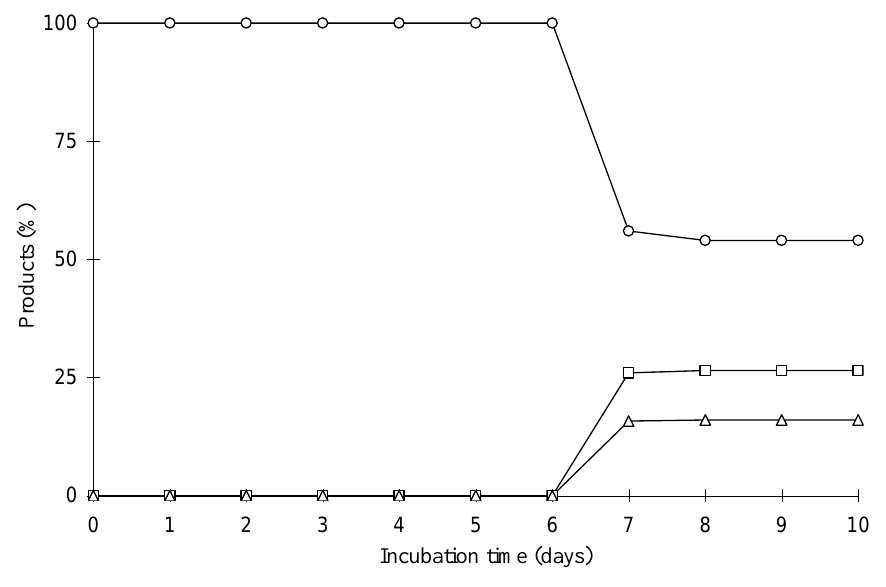
Figure 6. Time course in the biotransformation of lupeol by M. rouxii : ( (cid:123) ) lupeol; ( (cid:133) ) compound 4 ; ( (cid:85) ) compound 5